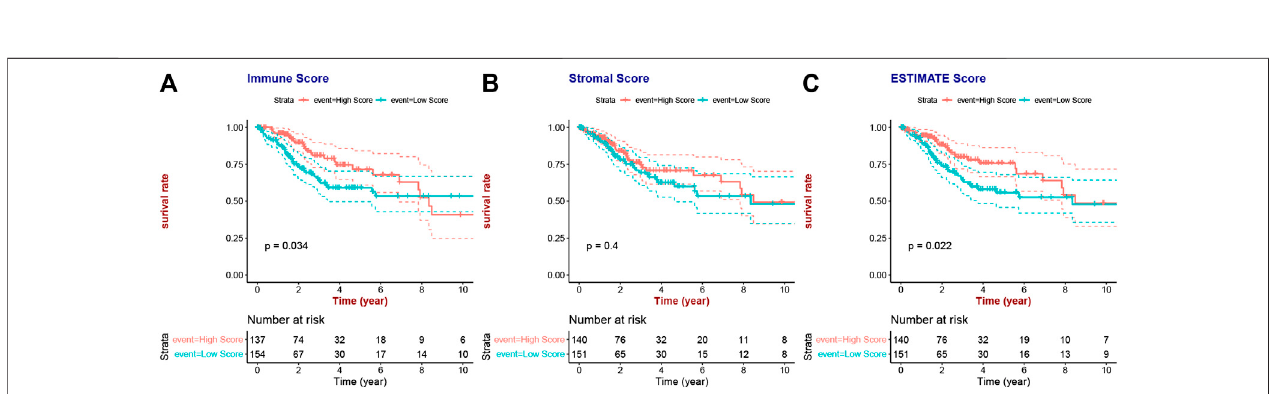
FIGURE 2 | Associations between immune/stromal/ESTIMATE scores and CESC patients ’ prognosis.